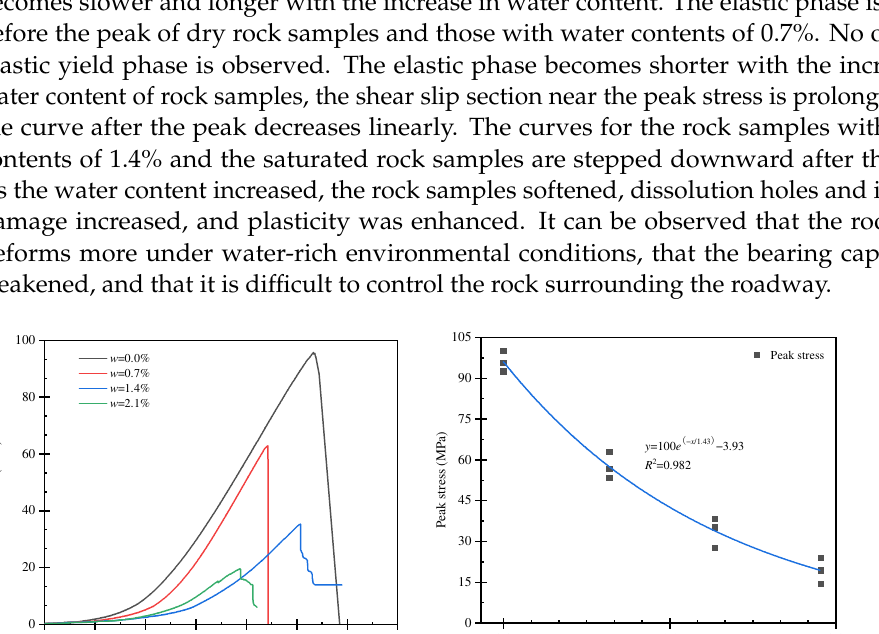
Table 3. Peak stress of rock samples with different water content.